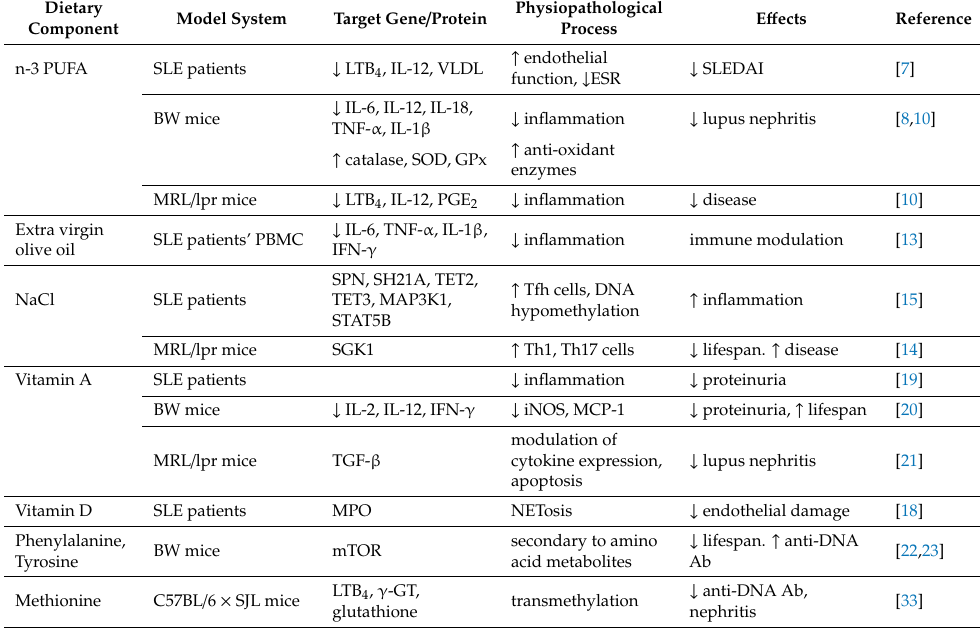
Table 1. Dietary components with possible impact on